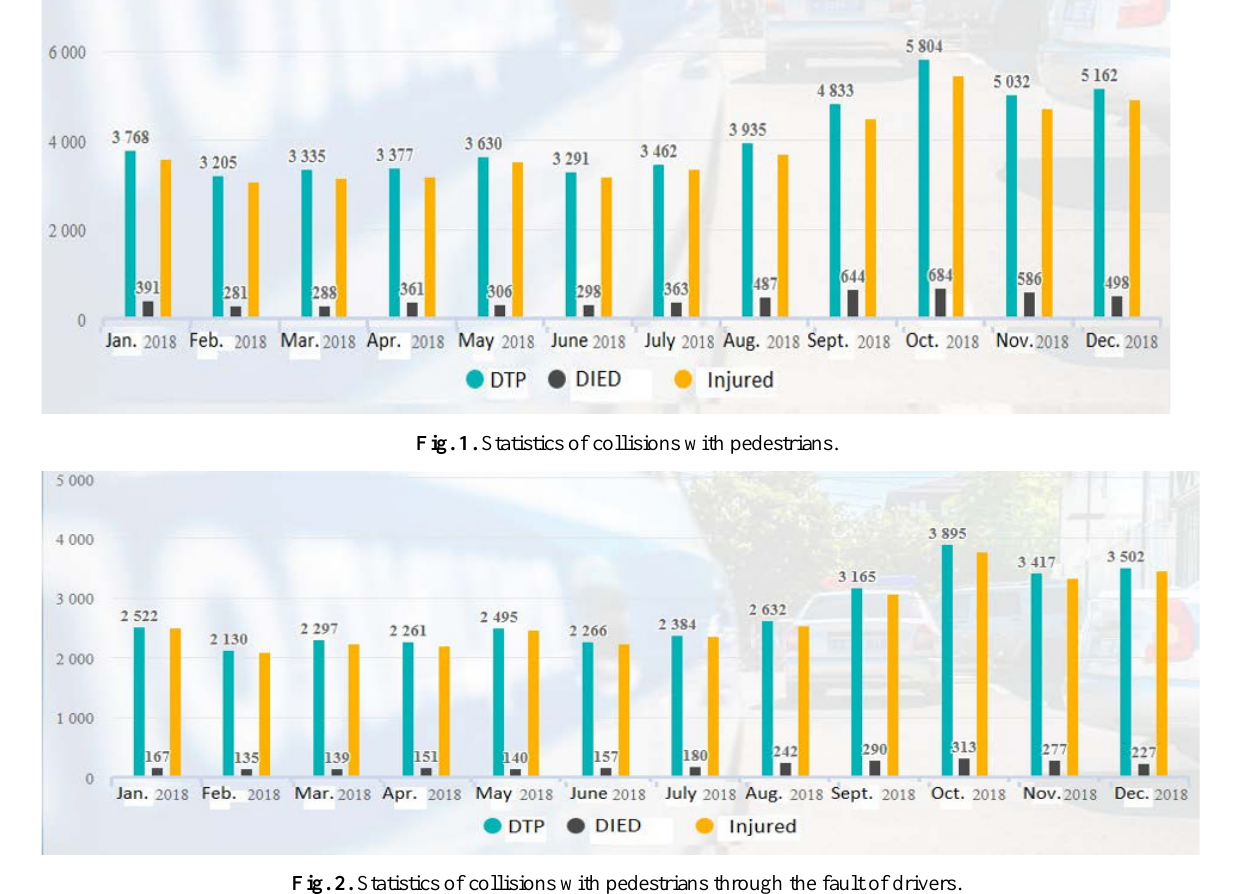
Fig. 2. Statistics of collisions with pedestrians through the fault of drivers.